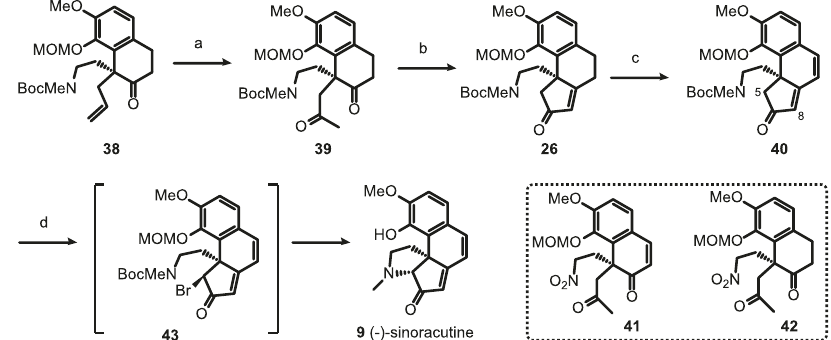
Fig. 4 Total synthesis of (-)-sinoracutine (9). Reagents and conditions: (a) PdCl 2 (0.1 equiv), O 2 , NMP/H 2 O = 8/1, 78%; (b) KO t Bu (1.2 equiv), toluene/ t BuOH = 20/1, 0 °C to rt, 91%; (c) DDQ (5.0 equiv), DCE, 50 °C, 81%; (d) LHMDS (1.5 equiv), NBS (1.2 equiv), − 78 °C, THF, then TFA, DCM, rt, 72%. NMP N- methyl-2-pyrrolidinone, DDQ 2,3-dichloro-5,6-dicyano-1,4-benzoquinone, DCE 1,2-dichloroethane, NBS N -bromosuccinimide, TFA tri fl uoroacetic acid.